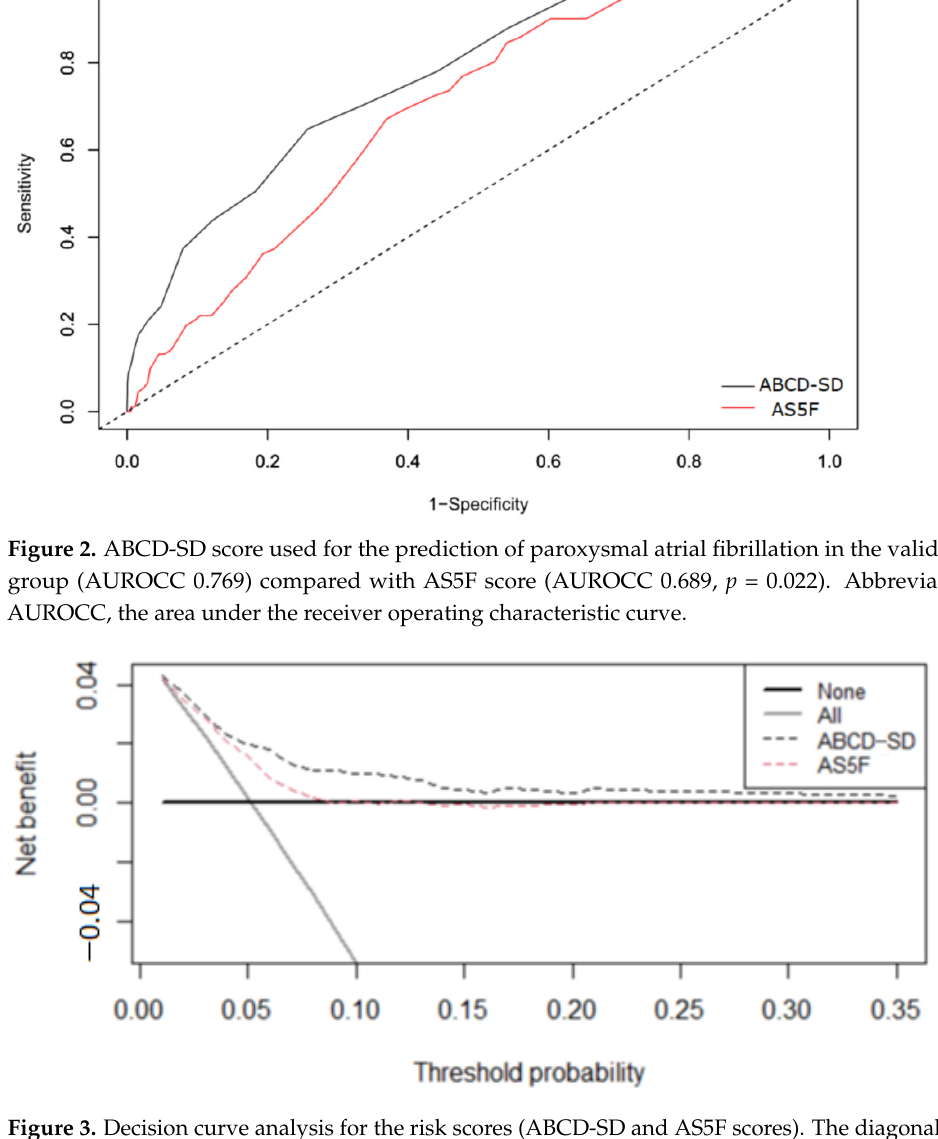
Figure 3. Decision curve analysis for the risk scores (ABCD-SD and AS5F scores). The diagonal gray line indicates the net benefit assuming all patients are at risk of paroxysmal atrial fibrillation, and the horizontal black line assumes no patients are at risk of paroxysmal atrial fibrillation.